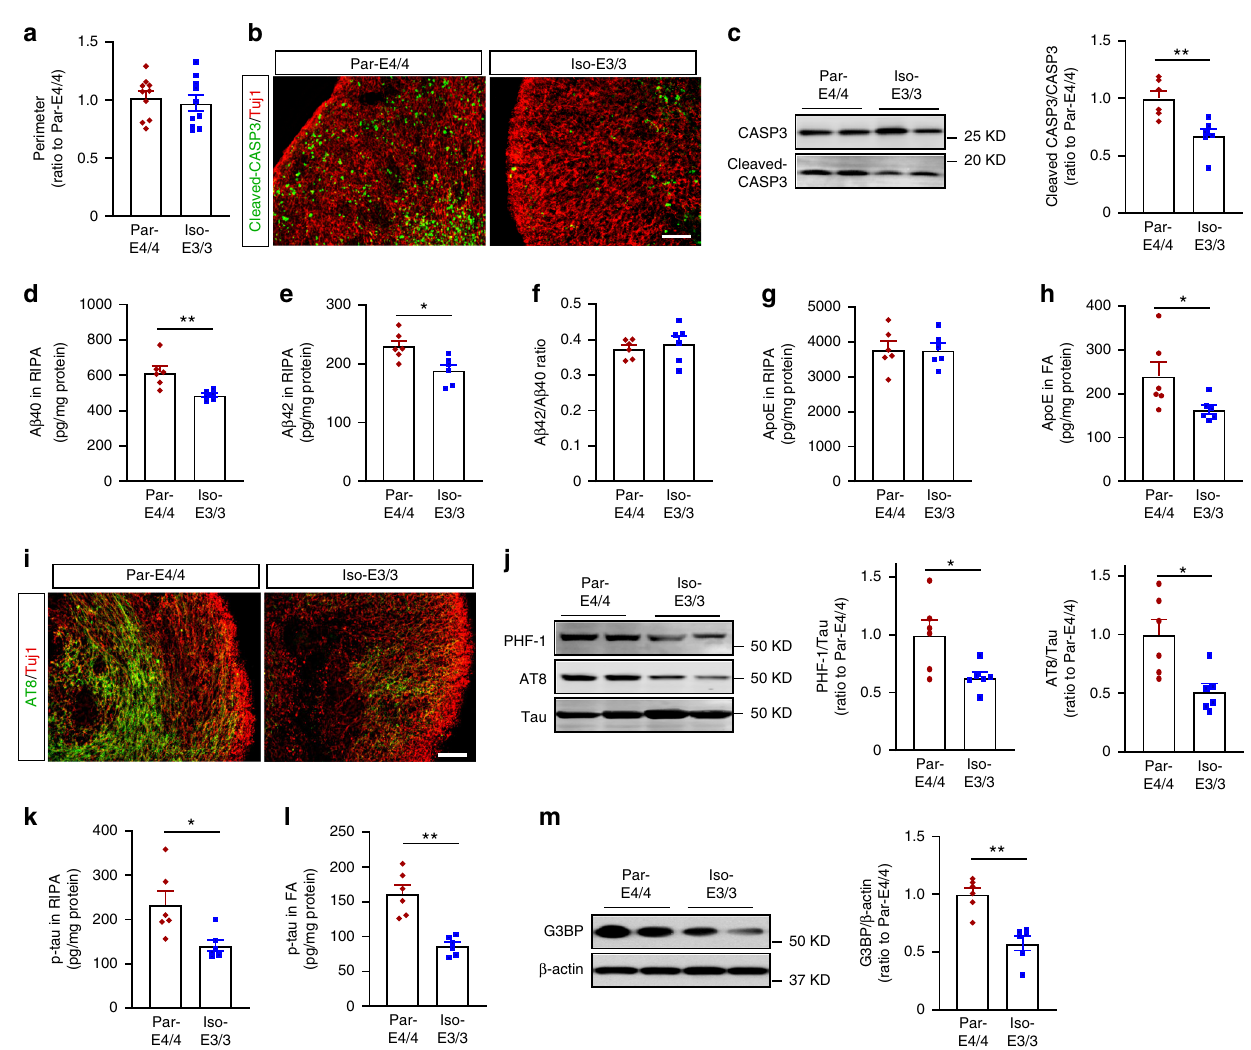
Fig. 7 Isogenic conversion of APOE4 to APOE3 attenuates AD-related phenotypes in cerebral organoids. The iPSC-derived cerebral organoids from an AD patient carrying APOE ε 4/ ε 4 (Par-E4/4) and the APOE ε 3/ ε 3 isogenic line (Iso-E3/3) were analyzed at week 12. a The perimeters of cerebral organoids were measured ( n = 10). b Representative images of cellular apoptosis with the immunostaining for cleaved CASP3. Scale bar: 100 μ m. c Cleaved CASP3 and CASP3 levels in the lysates were analyzed by western blotting and quanti fi ed ( p = 0.0043). d – f Amounts of A β 40 ( d : p = 0.0043) and A β 42 ( e : p = 0.0152) in RIPA fraction were measured by ELISA. Data were normalized to individual protein concentrations. The ratio of A β 42/A β 40 ( f ) was calculated accordingly. g , h Amounts of apoE in RIPA ( g ) and FA ( h : p = 0.0411) were measured by ELISA. Data were normalized to individual total protein concentrations. i Representative images of the immunostaining for p-tau with AT8 antibody. Scale bar: 100 µ m. j Total tau and p-tau in RIPA lysates were analyzed by western blotting and quanti fi ed. The p-tau detected by AT8 antibody and PHF1 antibody were normalized to total tau (AT8: p = 0.0152, PHF1: p = 0.0411). k , l Amounts of p-tau in RIPA ( k : p = 0.0152) and FA ( l : p = 0.0022) were measured by ELISA. Data were normalized to individual total protein concentration. m G3BP, levels in RIPA lysates were analyzed by western blotting and quanti fi ed. The levels of G3BP were normalized to β -actin ( p = 0.0022). c – h , j – m Lysates of 4 – 5 cerebral organoids were analyzed as one sample. All data are expressed as mean ± SEM ( n = 6).